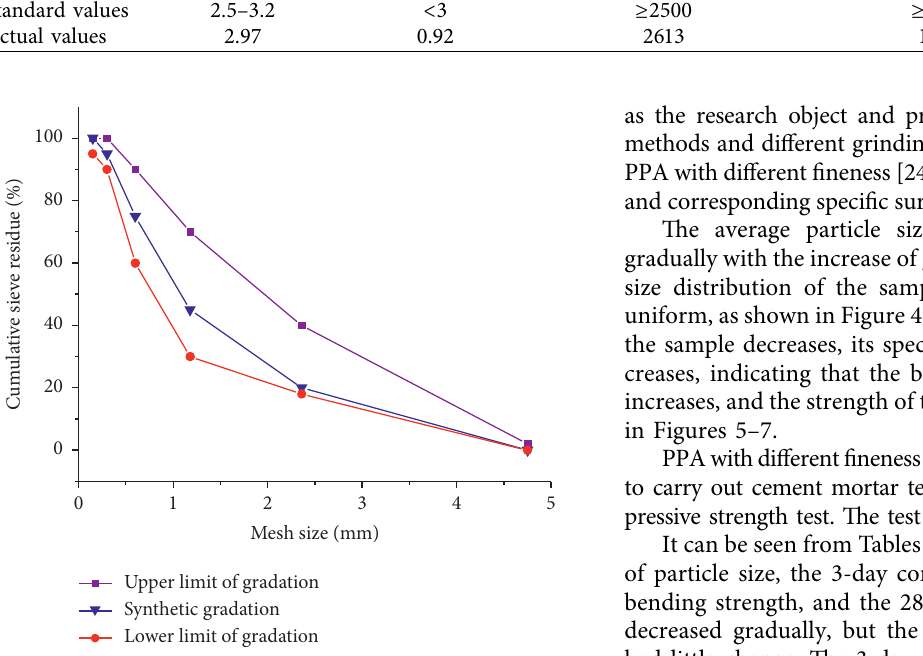
Figure 3: Grading curve of fine